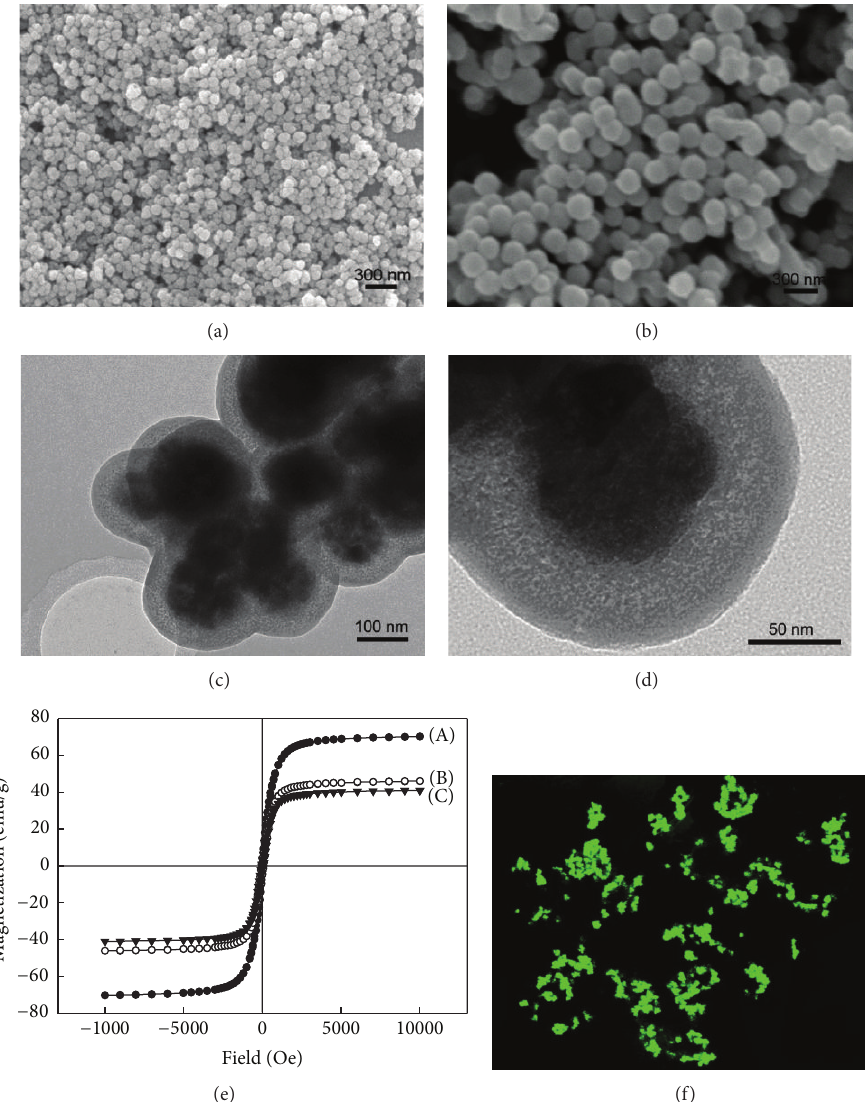
Figure 1: SEM images of pure Fe 3 O 4 nanoparticles and MFMSNs ((a), (b)). HRTEM images of MFMSNs ((c), (d)). The magnetic hysteresis loops (e) of pure Fe 3 O 4 nanoparticles (A), MFMSNs (B), and MFMSNs-HP (C). Confocal laser scanning microscopy image of MFMSNs